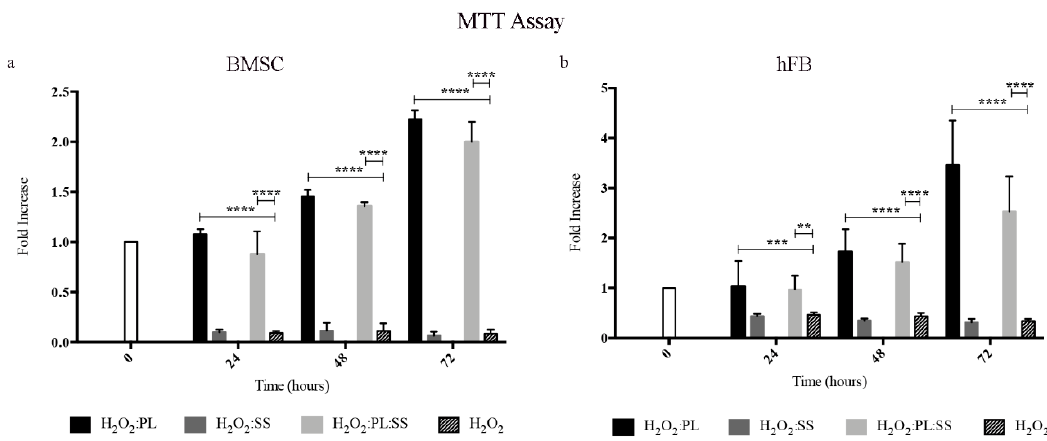
Figure 7. Protection against oxidative stress. Viability of BMSC ( panel a ) and hFB ( panel b ) after an oxidative stress induced by H 2 O 2 (1 mM) and the effect of a contemporary treatment with Sericin (SS), Platelet Lysate (PL), and PL:SS. Cell viability was determined by MTT assay, **** p < 0.0001, *** p < 0.001, ** p < 0.01.